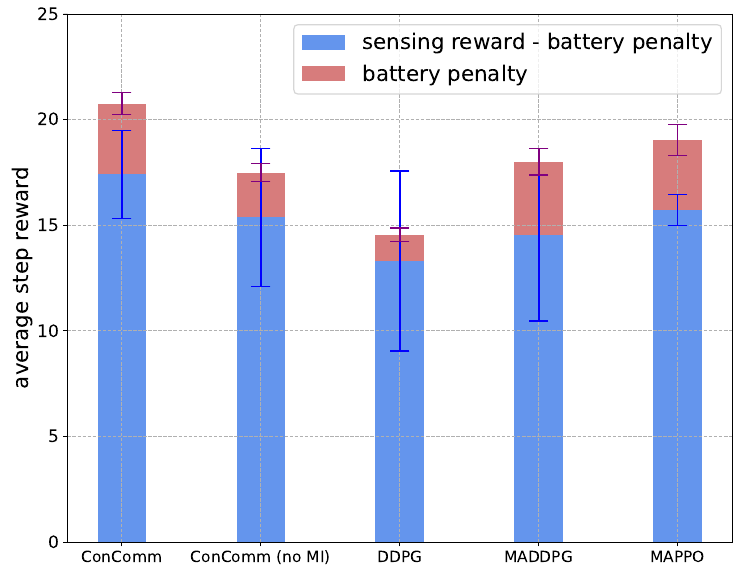
Figure 6. The performance of different algorithms in the execution phase. As presented, our proposed ConComm achieves the best performance (the blue part) among the algorithms. In particular, the sensing reward (the blue+red part) also outperforms other algorithms significantly. This is because the vehicles in ConComm can avoid repeated sensing through communication. The ConComm (no MI) can also have high performance. It achieves lower battery penalty because the vehicles’ behaviors will not be affected by the communication messages explicitly. DDPG also performs well in charging since each vehicle only cares about its own reward. However, the global sensing reward can be quite limited, which may be caused by the lack of coordination. For